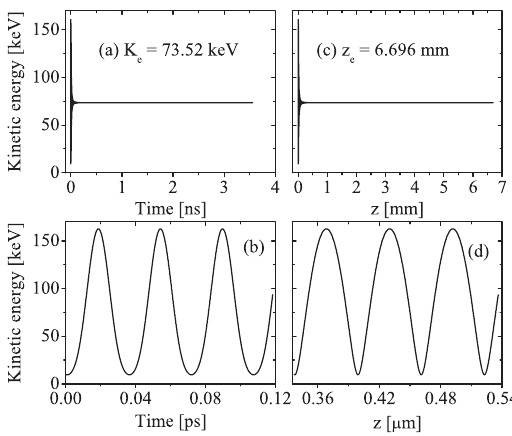
FIG. 2. Single (cid:2) -particle kinetic energy vs the time [(a) and (b)], and the forward excursion distance of travel [(c) and (d)]. The beams are identical, with (cid:3) ¼ 10 : 6 (cid:1) m , c 0 ¼ 0 , and w 0 ¼ 0 : 7 (cid:3) , power P ¼ 1 TW focused to an intensity of I (cid:8) 9 : 354 (cid:3) 10 17 W = cm 2 , and the crossing angle is 2 ’ ¼ 10 (cid:1) . Integration time is 3.558 ns. K e is exit kinetic energy and z e is exit z coordinate. In (b) and (d) we merely zoom in on the leftmost small parts of (a) and (c), respectively, which means they reflect the dynamics right inside the interaction